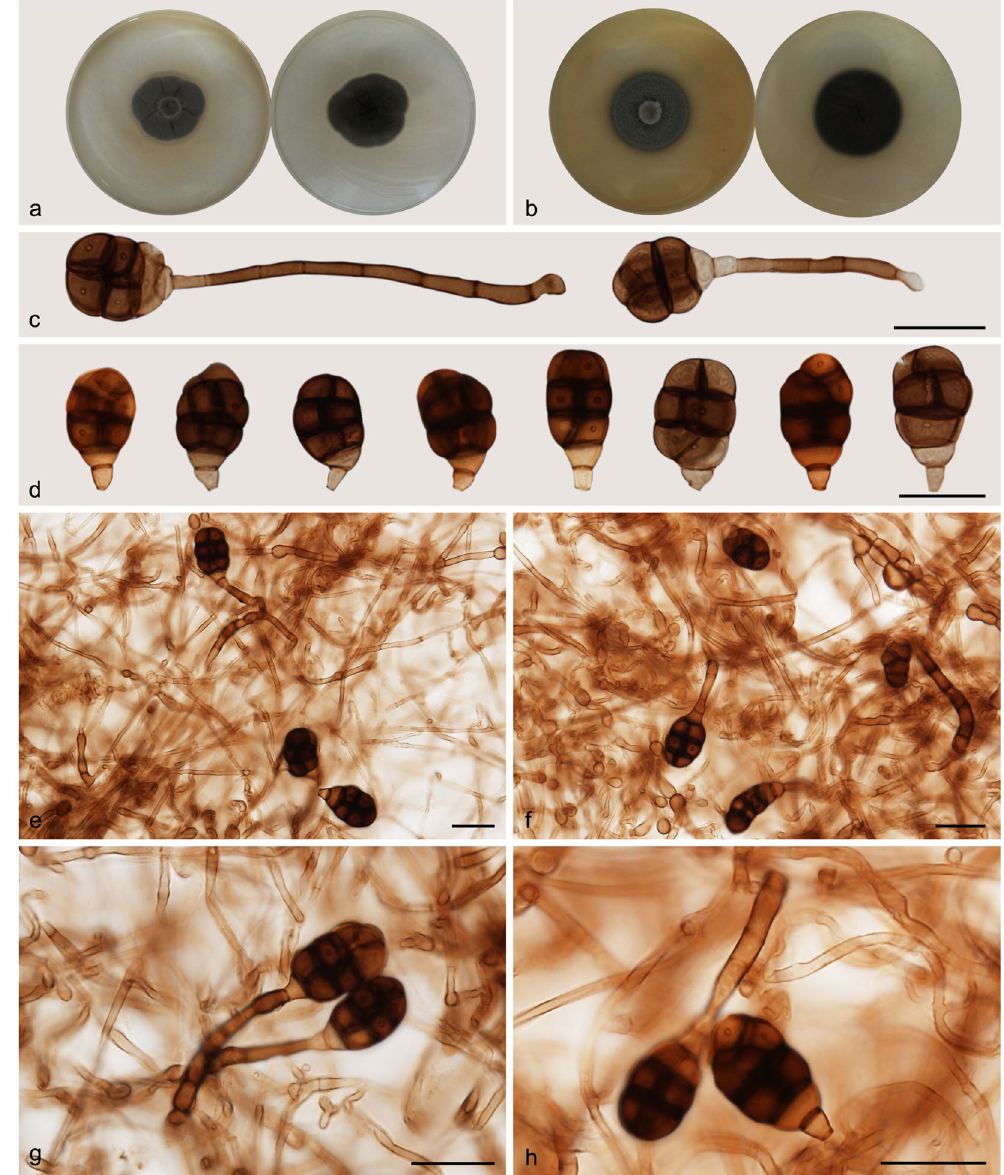
Figure 3. Acrodictys elaeidicola. ( a ) Colony on PDA (surface and reverse). ( b ) Colony on MEA (surface and reverse). ( c , d ) From natural substrate (HSAUP H5528): ( c ) Conidiophores with conidia, ( d ) Conidia. ( e – h ) From PDA (CGMCC 3.18642): Conidiophores and conidia. — Scale bars = 20 μ